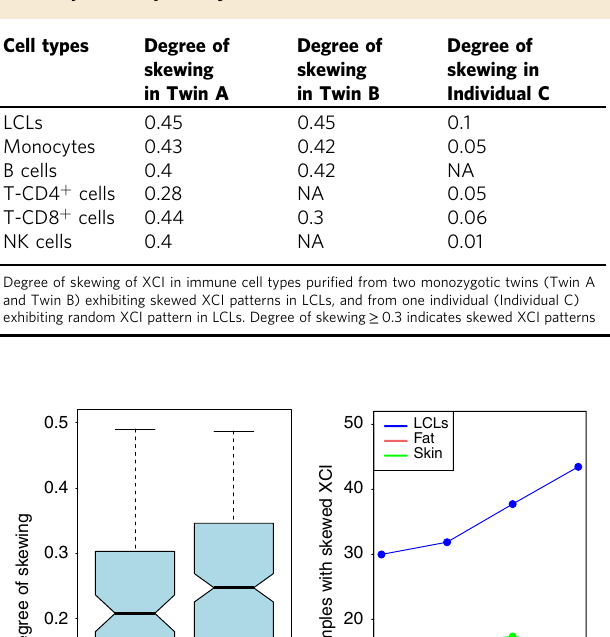
Table 3 XCI skew in LCLs in this study is representative of XCI in puri fi ed primary immune